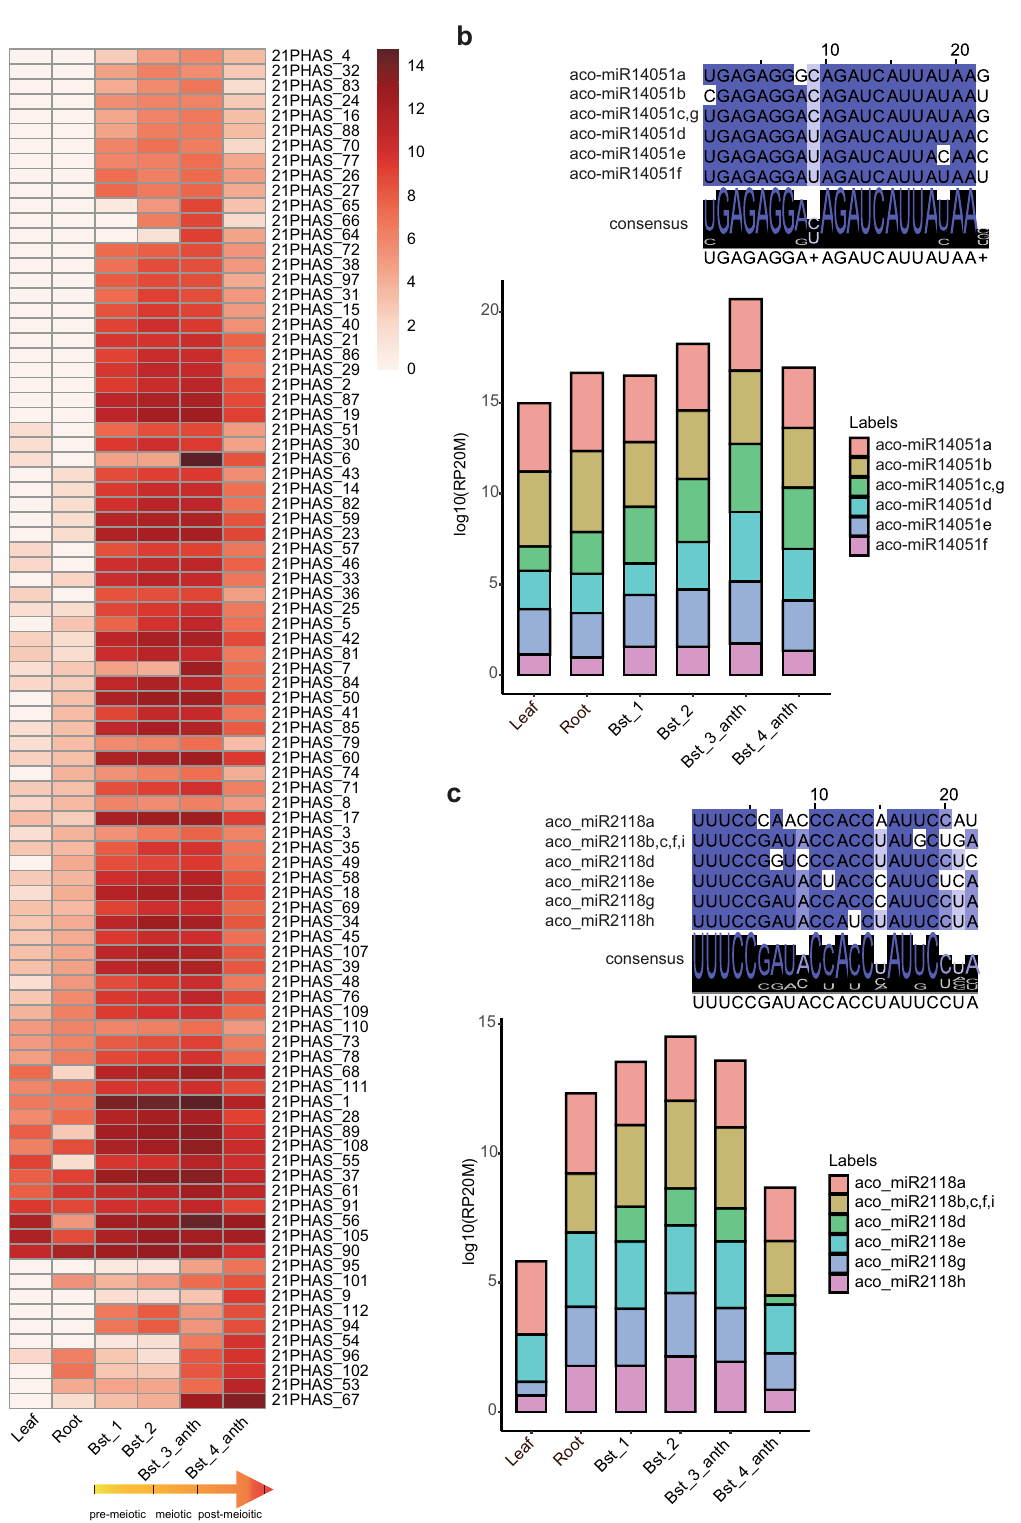
Fig. 4 Conservation of reproductive 21 nt phasiRNAs and their triggers in the basal eudicot columbine. a Expression of 21 nt reproductive phasiRNAs in different vegetative tissues and anther development stages in columbine. The lowermost ten loci are most enriched in stage 4. The yellow gradient arrow indicates the developmental stages of anthers. The key at the right indicates the abundance in units of log2(RP20M). Bst indicates bud stage, anth indicates anther. b Above: alignment of members of miR14051 in columbine. The degree of conservation is denoted by the intensity of the blue color and the consensus sequence of the alignment is shown in a sequence logo. Below: abundance of miR14051 members in log10(RP20M) in different tissues of columbine. c Similar to b but for the miR2118/482 family in columbine. Source data are provided as a Source Data fi